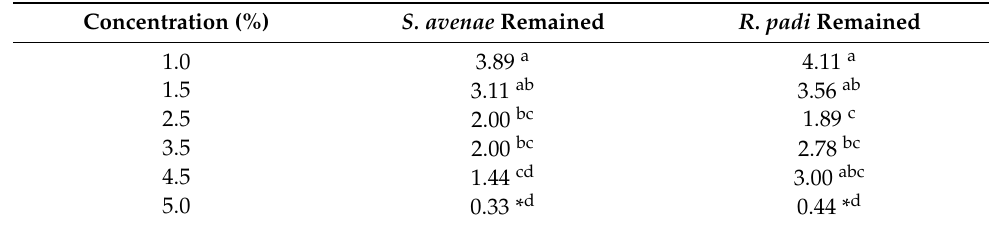
Table 9. Mean number of Sitobion avenae and Rhopalosiphum padi species of aphid that remained on the leaves from the six (6) concentrations of the essential oil (EO) of J. sabina and J. excelsa . Concentration (%)